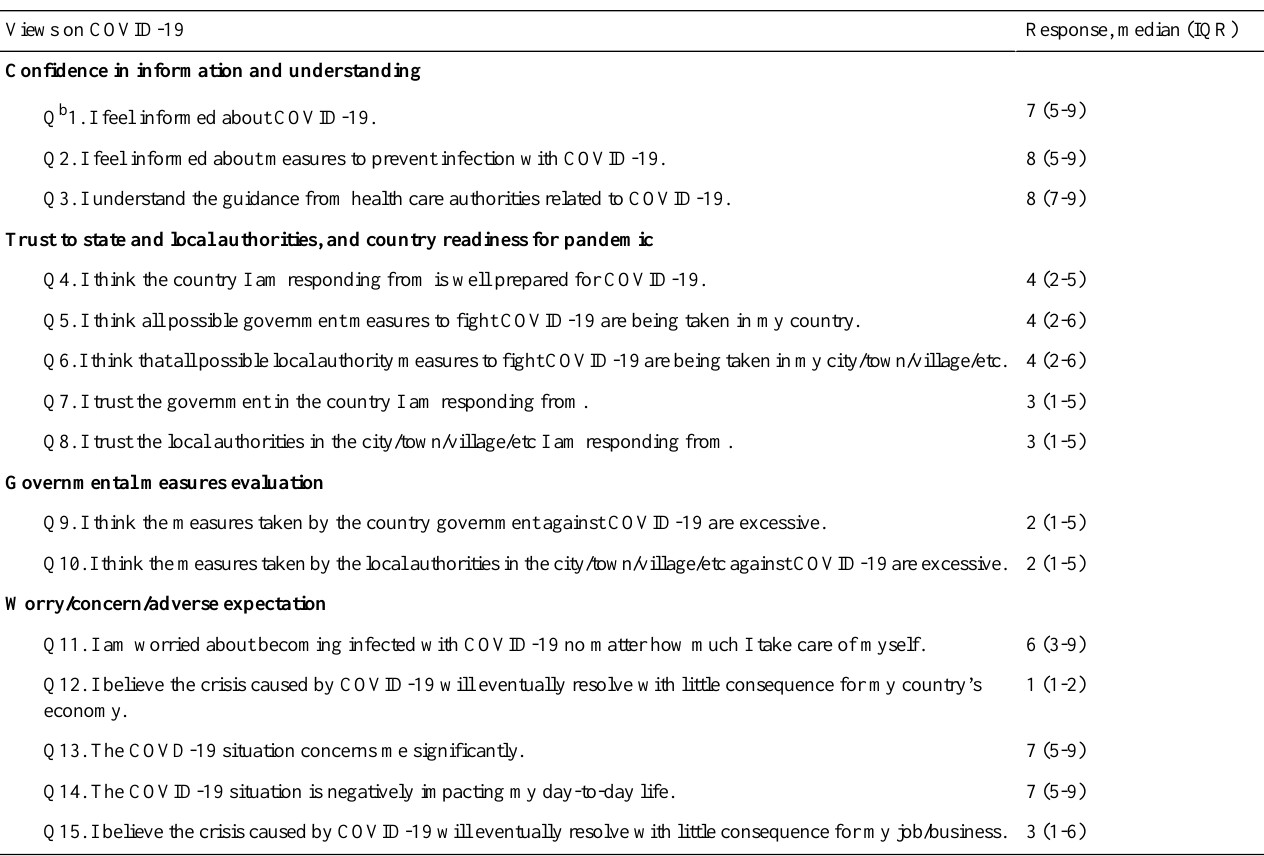
Table 3. Respondents answers to the questions addressing confidence, understanding, trust, and concerns. a